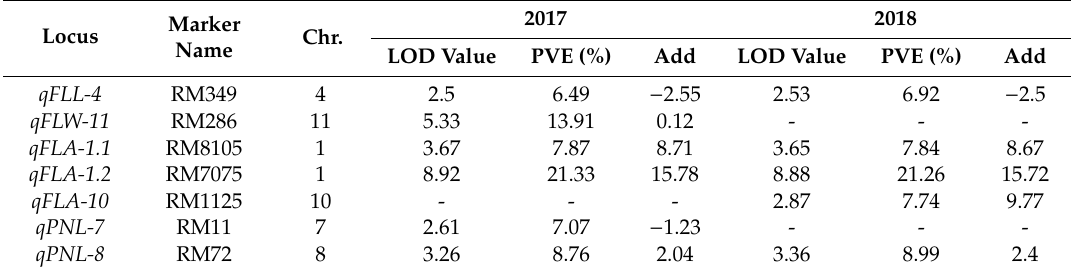
Table 4. Quantitative trait loci (QTLs) detected for the outcrossing traits in the CL-CSSL population. Marker Locus Chr. Name qFLL-4 RM349